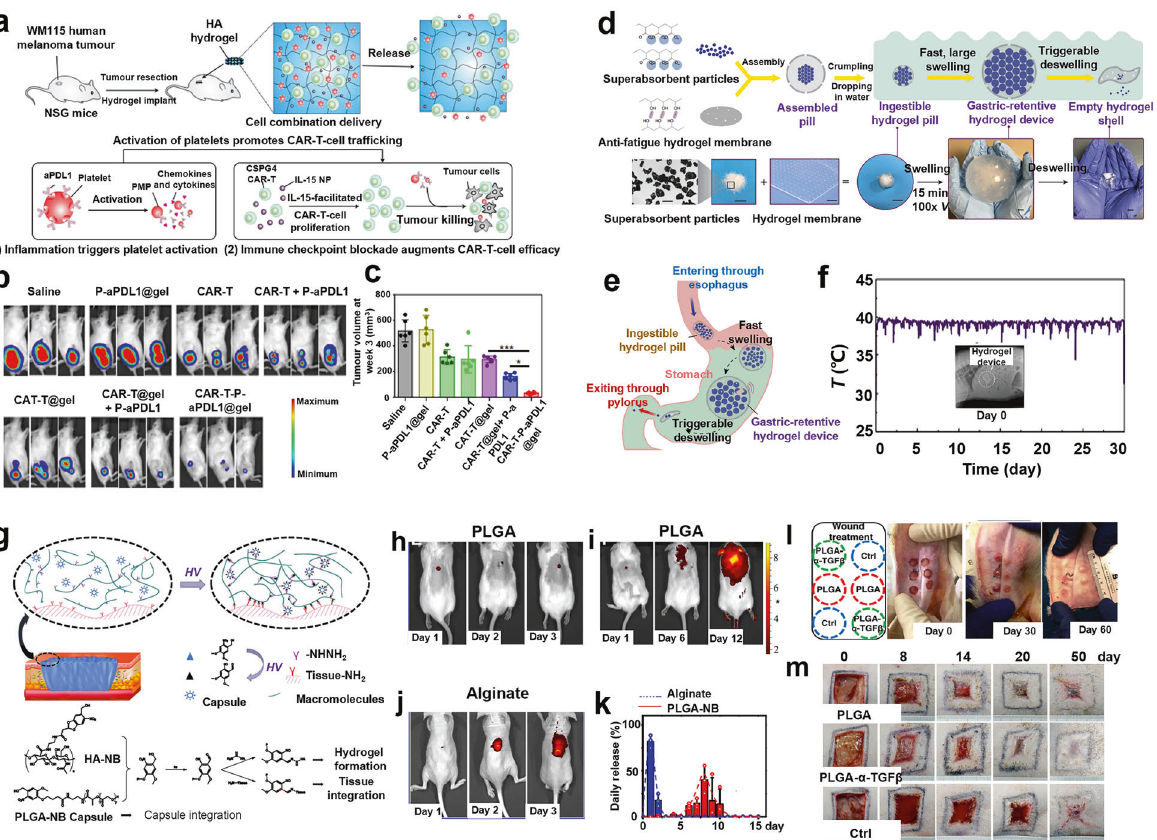
Fig. 11 The preclinical studies of hydrogel applications. a – c Preparation of a hyaluronic acid (HA)-based hydrogel that released CAR-T cells to target the human chondroitin sulfate proteoglycan 4 ( a ) and anti-PDL1-conjugated platelets for inhibiting post-surgery melanoma tumor recurrence ( b , c ). * p = 0.0486, *** p < 0.001 380 Copyright 2021, Springer nature. d – f Puffer fi sh-inspired ingestible hydrogel device ( d , e ) for long- term gastric retention and physiological monitoring like porcine gastric temperature ( f ). 411 Copyright 2019, Springer nature. g – m